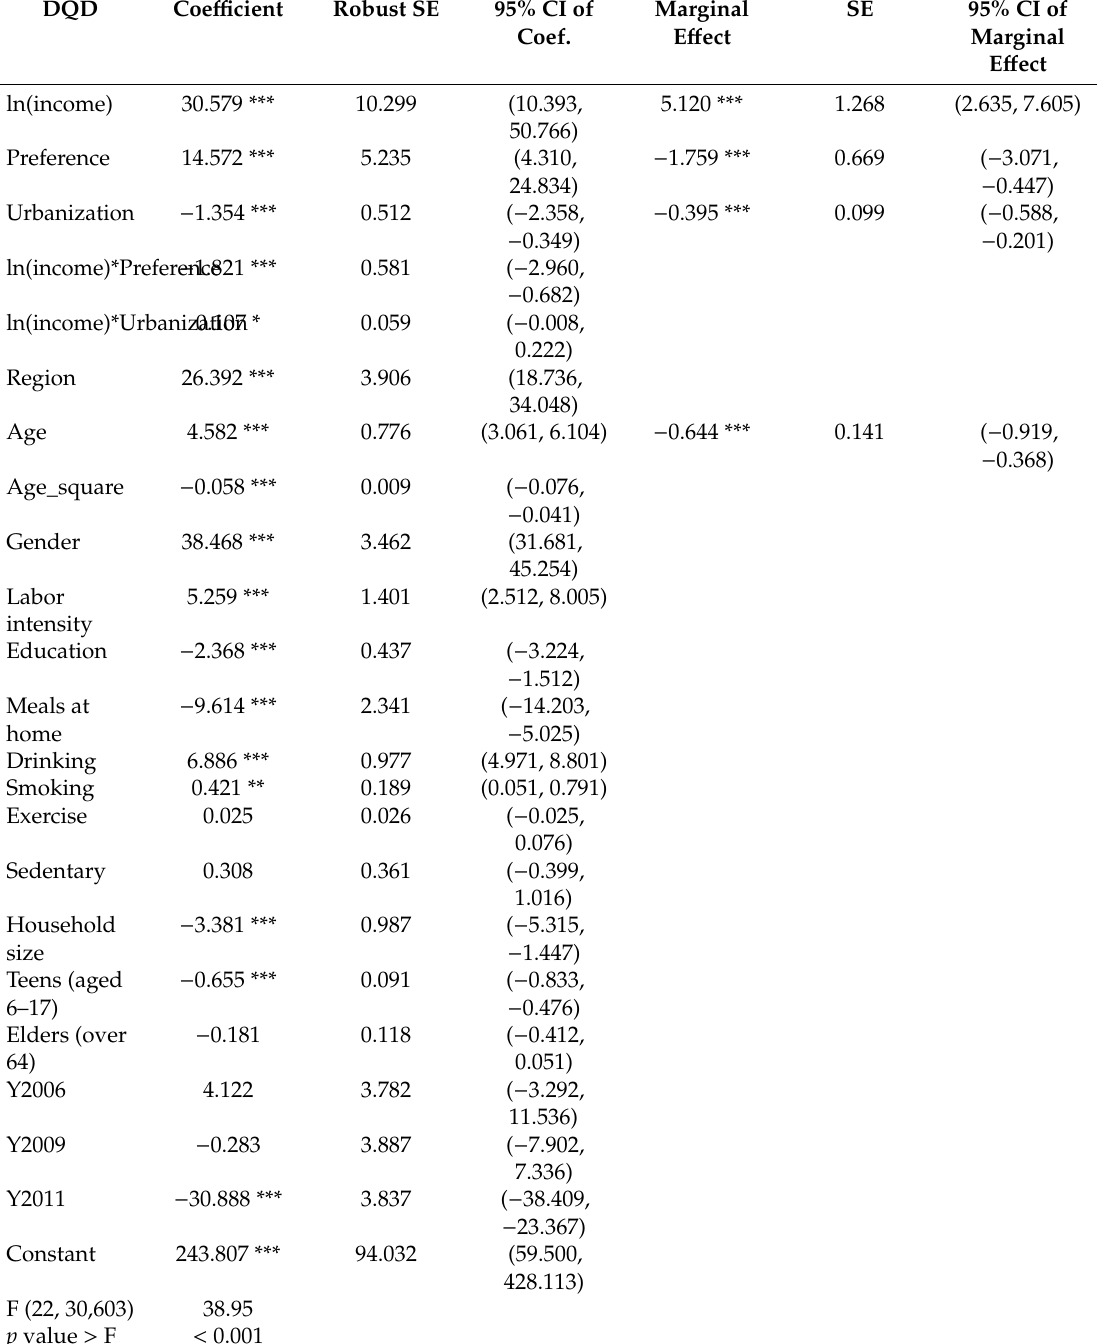
Table 3. Multivariate ordinary least squares regression (n =